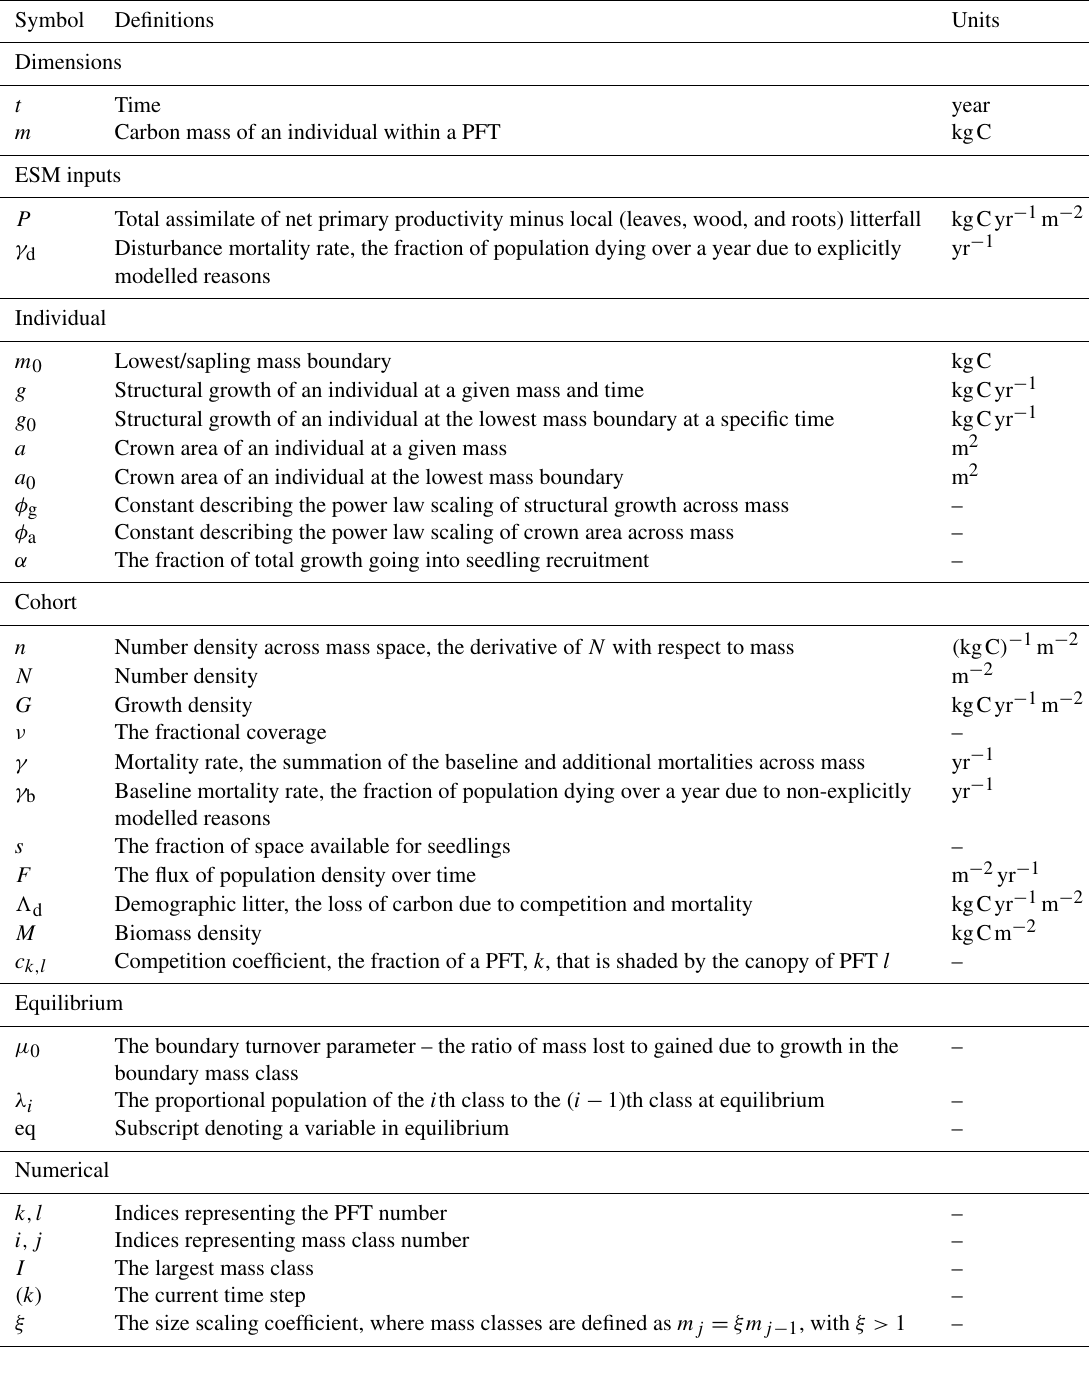
Table 1. Model variables, parameters, and